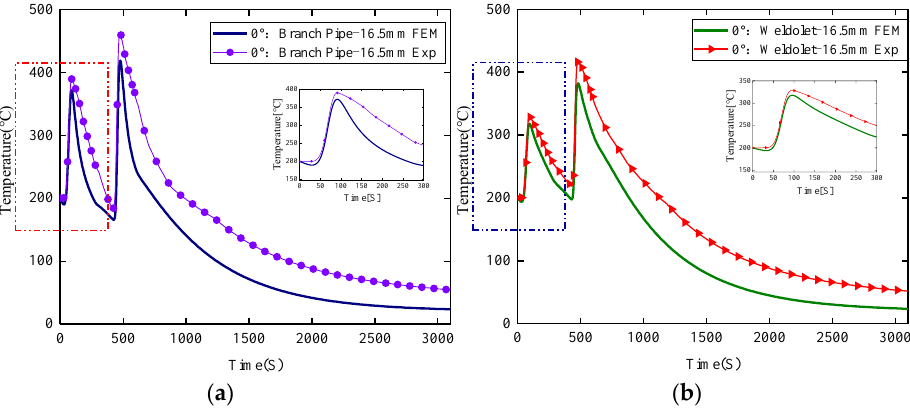
Figure 9. Comparison of predicted and measured values of transient temperature: ( a ) branch pipe side, ( b ) weldolet side.